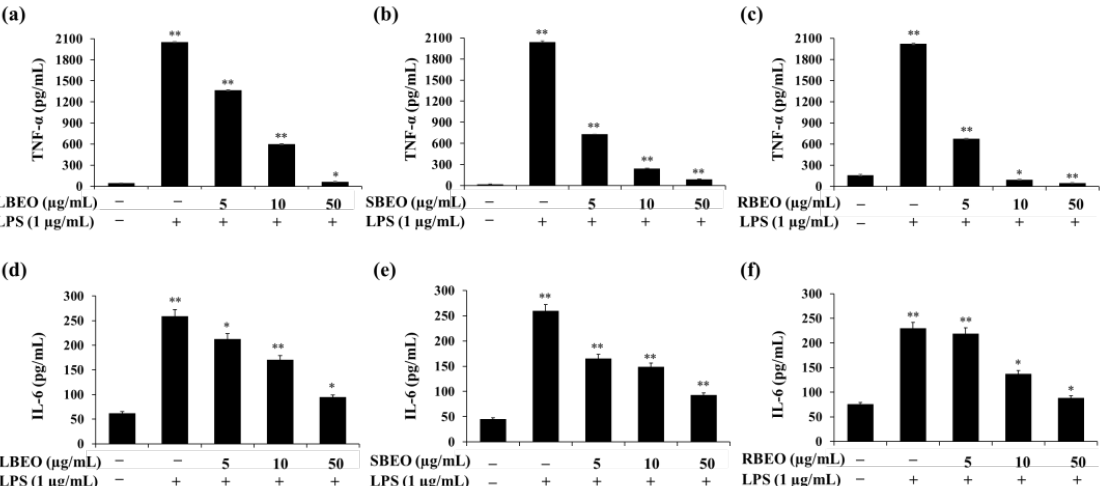
Figure 4. Inhibitory effects of LBEO, SBEO, and RBEO (5, 10, and 50 µ g/mL) on TNF- α and IL-6 production in RAW 264.7 macrophages. After 24 h of stimulation by LPS, the inhibition of TNF- α and IL-6 production by ( a , d ) LBEO, ( b , e ) SBEO, and ( c , f ) RBEO were quantified by ELISA. Cytokine concentrations were calculated using a standard curve. Data from three independent experiments were used to calculate mean values and standard deviation. * p < 0.05, ** p < 0.01 vs. the untreated group.